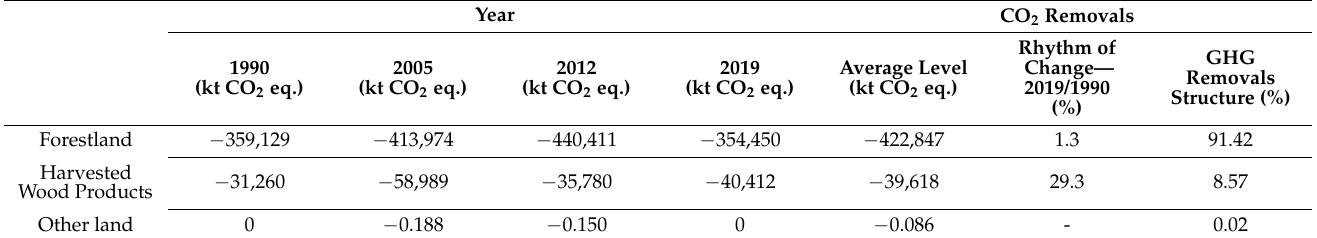
Table 3. LULUCF GHG removals structure by land use categories during 1990–2019, EU-27 + UK.